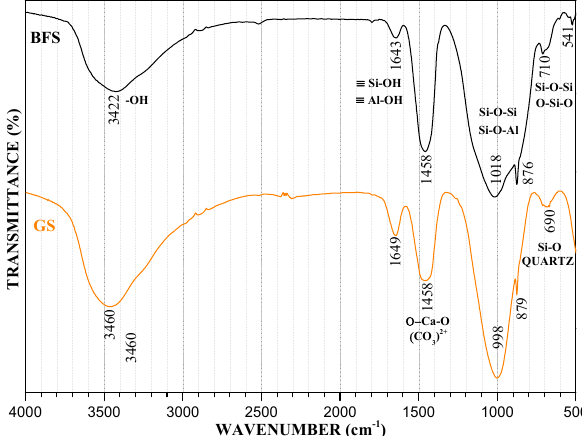
Figure 3. Fourier Transform Infrared Spectroscopy (FT-IR) spectrum of BFS and GE.